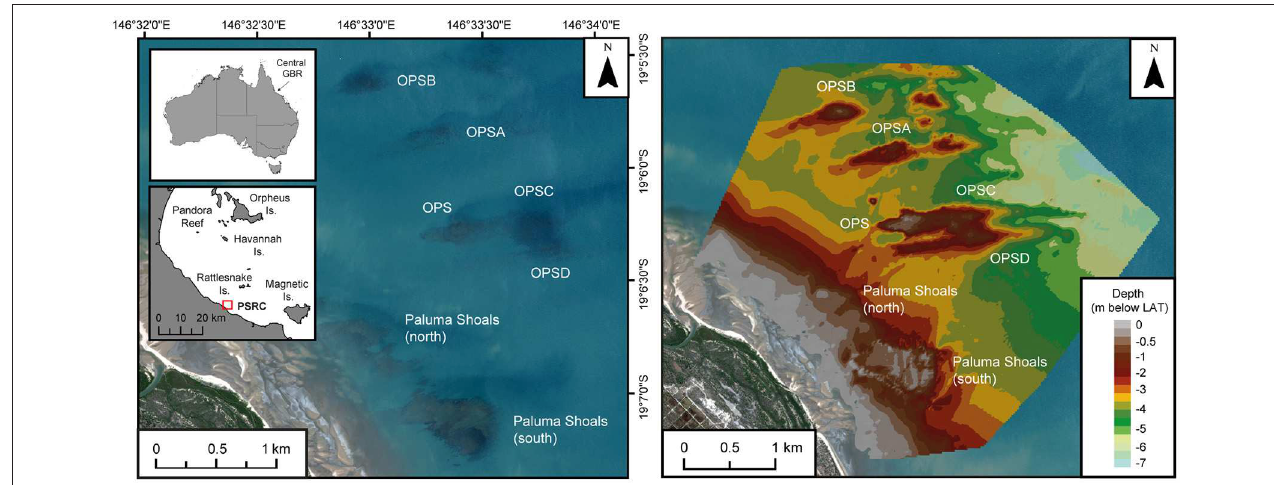
FIGURE 1 | Site map of the Paluma Shoals reef complex (PSRC) located within Halifax Bay on the central Great Barrier Reef, Australia. Satellite imagery and bathymetric seafloor model (m below lowest astronomical tide; LAT) show the position and morphology of the seven discrete nearshore turbid-zone coral reefs that comprise the complex. OPS [A, B, C, D], Offshore Paluma Shoals [A, B, C,